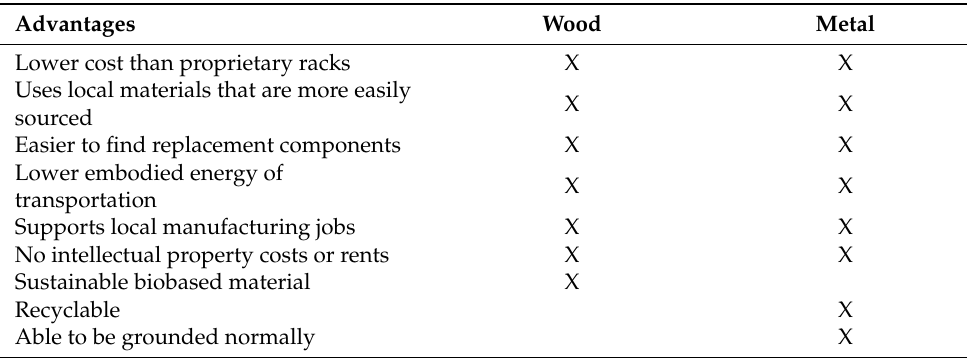
Table 4. Advantages of open-source wood-based and metal-based PV racking systems compared to conventional